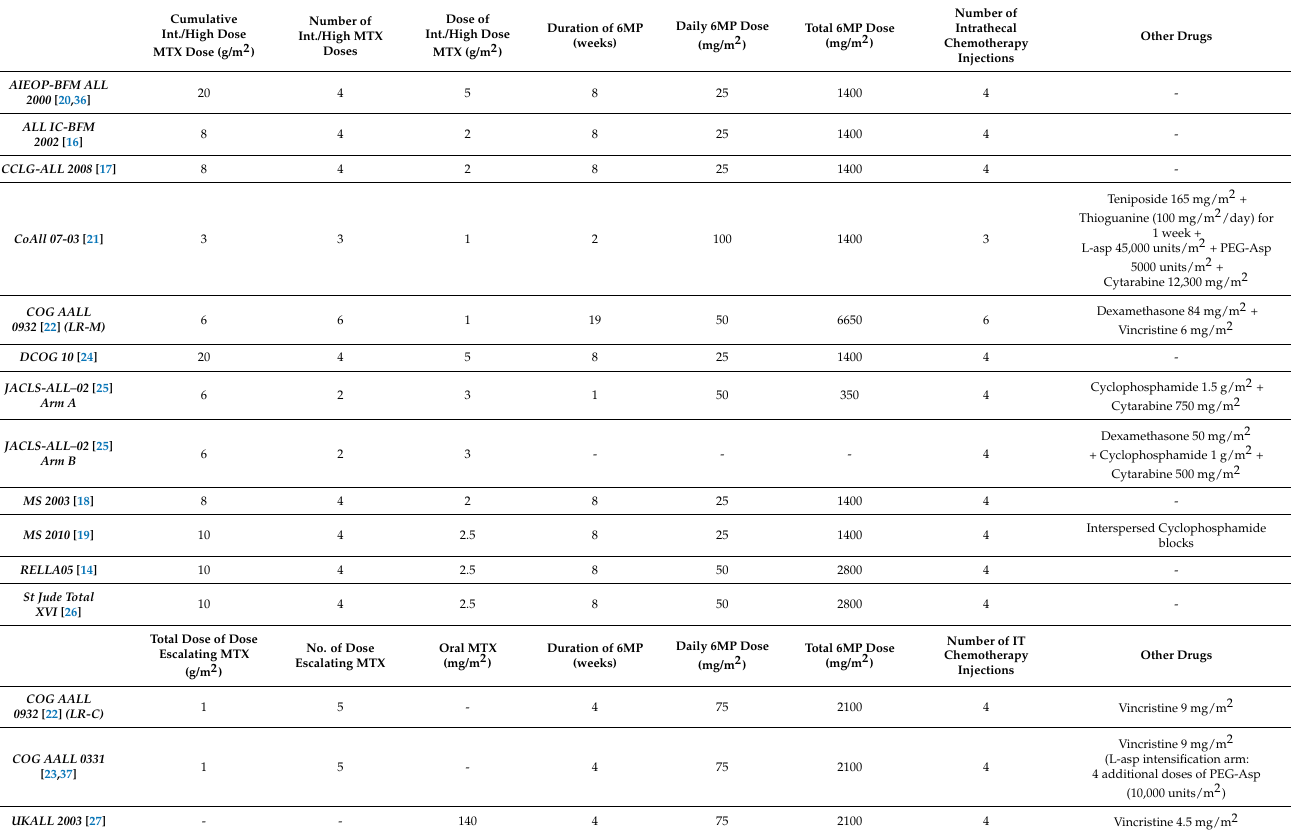
Table 3. Consolidation and MTX dosing across clinical